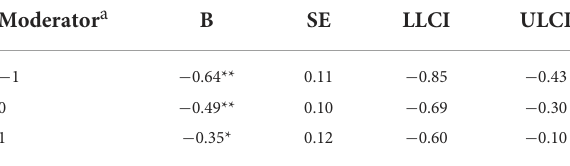
TABLE 7 Regression results for conditional indirect effects of mindfulness on symptom